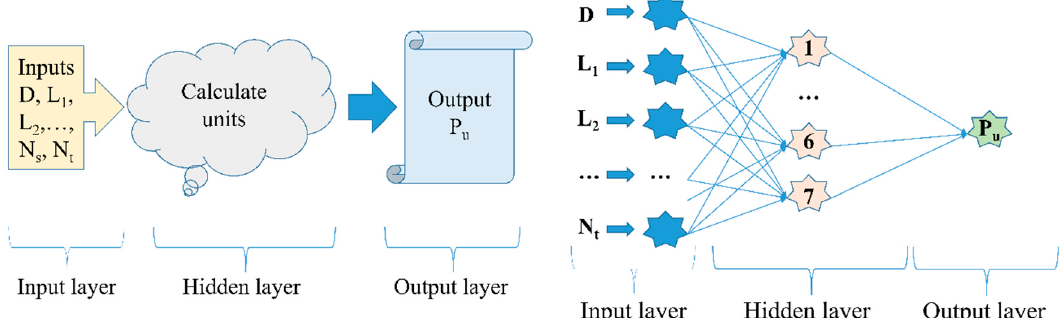
Figure 4. ( Left ) Schematic diagram of neural network and ( Right ) network architecture selection.